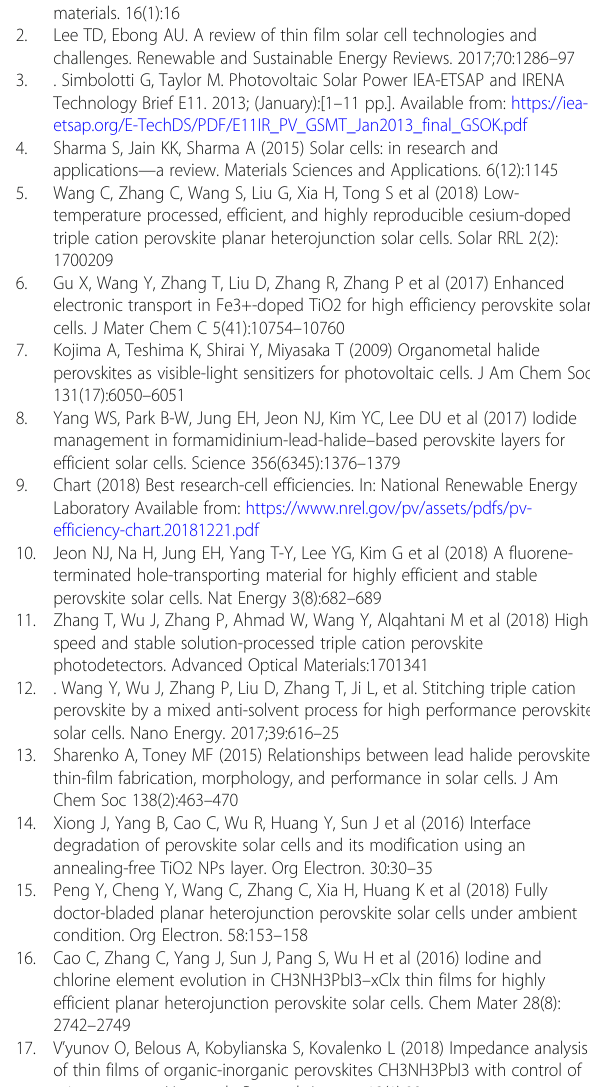
Additional file 1: Figure S1. UV-vis absorption spectra of solutions: 1 – PbI 2 ; 2 – PbI 2 and CH 3 NH 3 I (1:1); 3 – PbI 2 and CH 3 NH 3 I (1:2); 4 – PbI 2 and